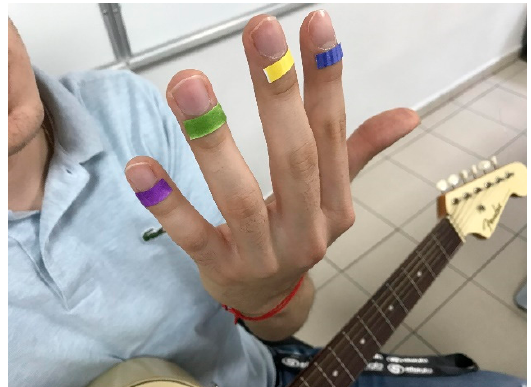
Figure 1. Color-coded markers used on fingers.